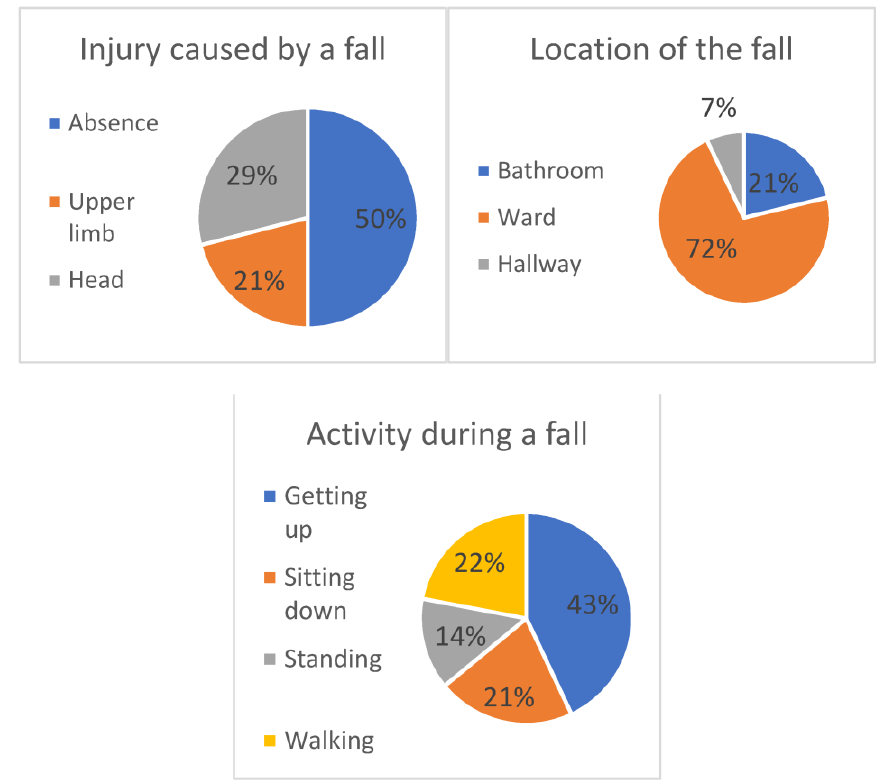
Figure 1. Circumstances of falls (location, activity, and injury).